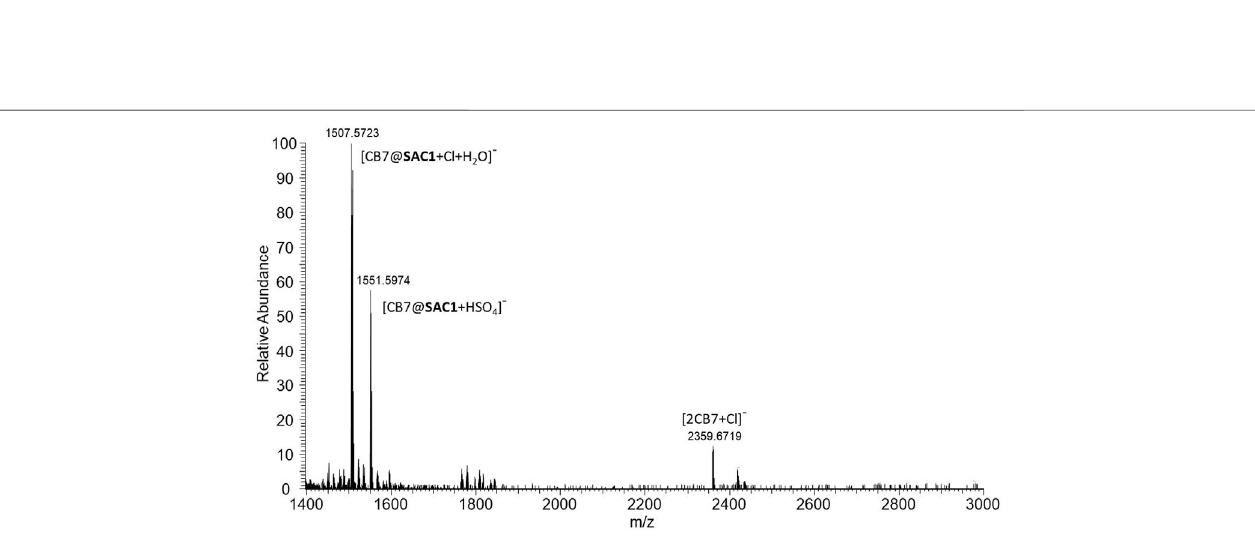
Frontiers in Chemistry |